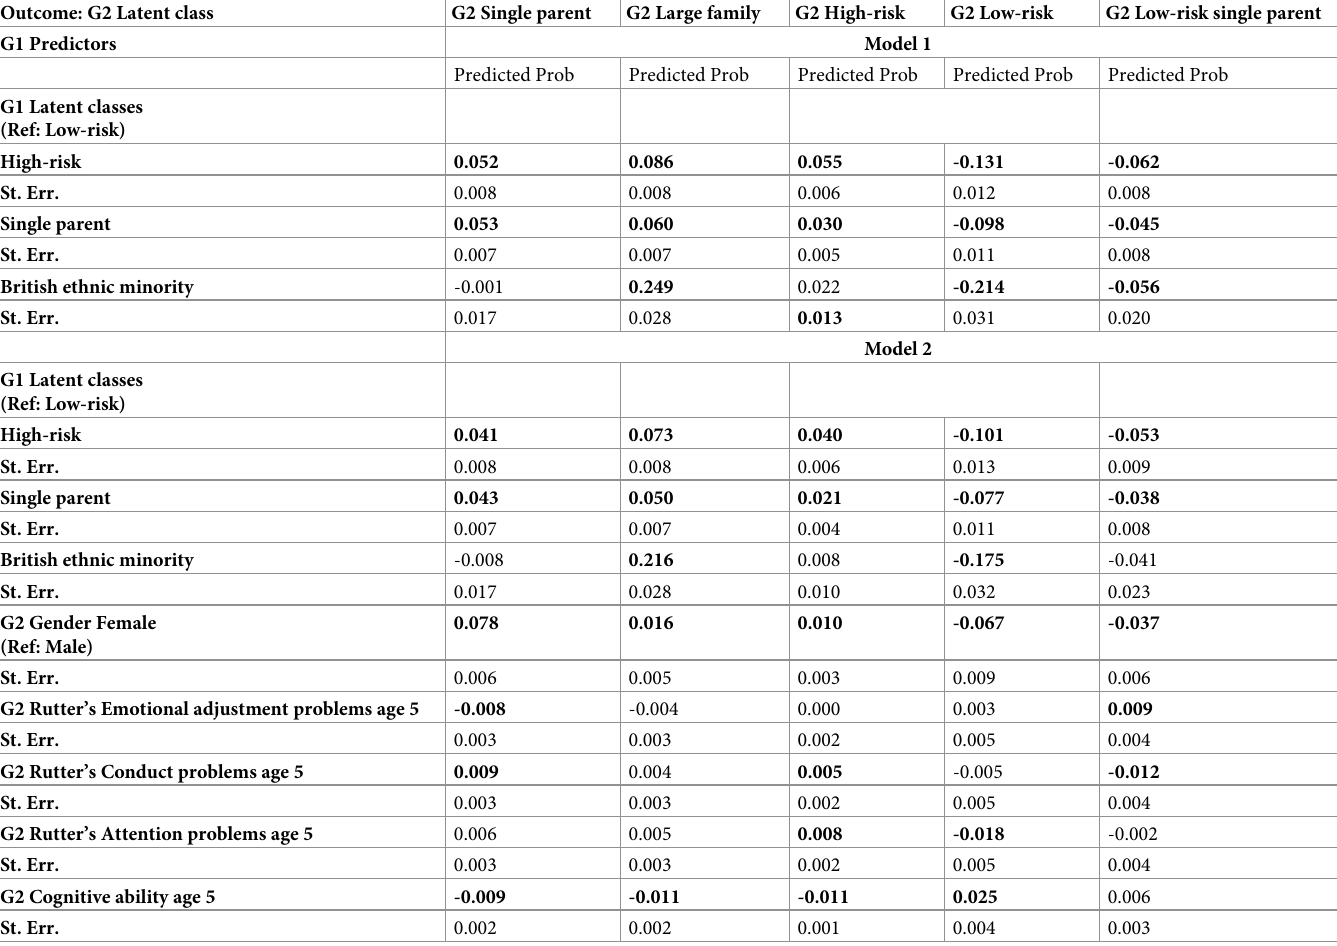
Table 7. Marginal predicted probabilities of G2 latent class membership by